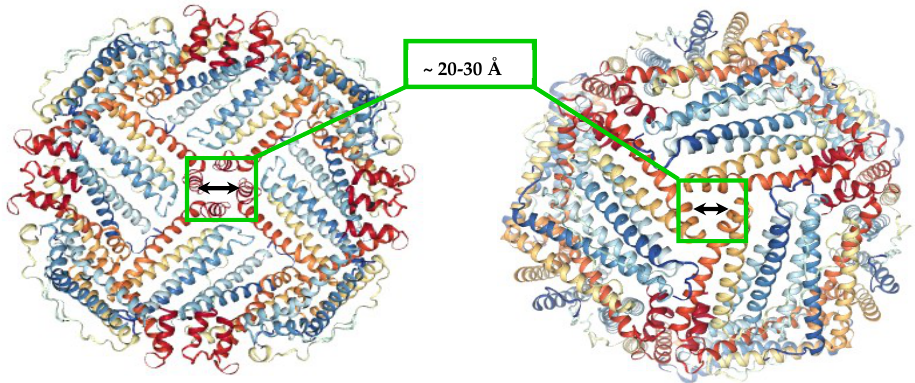
Figure 1. Ferritin molecule (PDB 1R03) with highlighted hydrophobic four-fold (left) and hydrophilic three-fold channels (right) that allow the transport of small molecules and ions to the inner cavity.